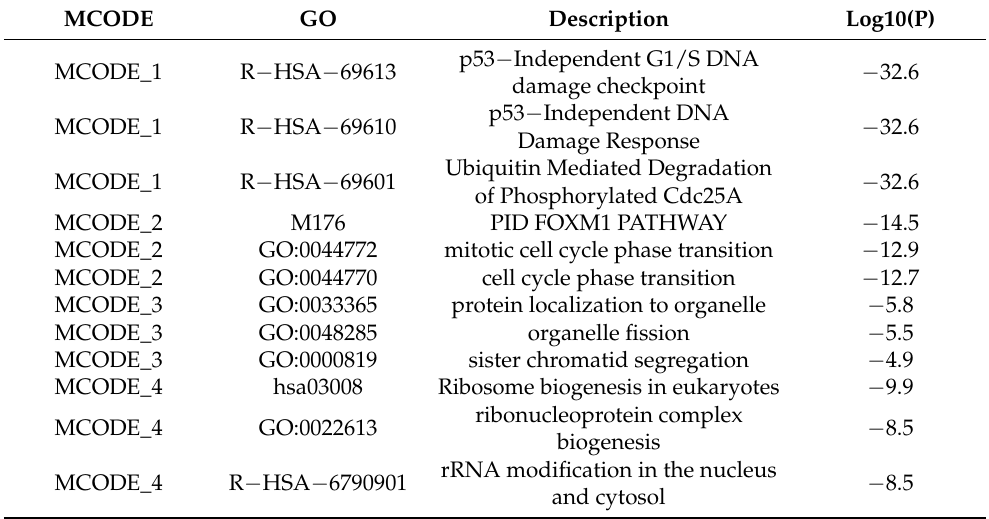
Table 4. Top 3 MCODE terms